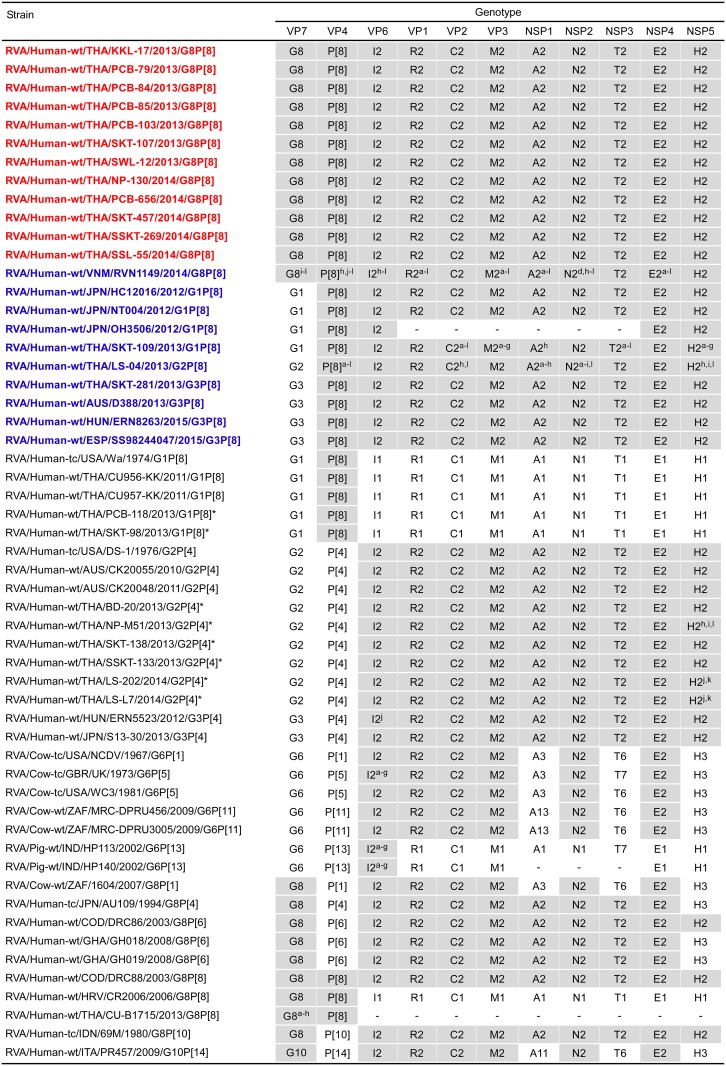
Genotype natures of the 11 gene segments of 12 Thai DS-1-like intergenogroup reassortant strains having G8P[8] genotypes, KKL-17, PCB-79, PCB-84, PCB-85, PCB-103, SKT-107, SWL-12, NP-130, PCB-656, SKT-457, SSKT-269, and SSL-55, compared with those of selected human and animal strains.The 12 study strains are shown in red, while other DS-1-like intergenogroup reassortant strains are shown in blue. Asterisks indicate co-circulating strains, PCB-180, SKT-98, BD-20, NP-M51, SKT-138, SSKT-133, LS-202, and LS-L7, reported in this and the preceding studies [19]. Gray shading indicates the gene segments with genotypes identical to those of the 12 strains. “−” indicates that no sequence data were available in the DDBJ and EMBL/GenBank data libraries. aThe gene segments that are most similar to those of strain KKL-17. bThe gene segments that are most similar to those of strain PCB-79. cThe gene segments that are most similar to those of strain PCB-84. dThe gene segments that are most similar to those of strain PCB-85. eThe gene segments that are most similar to those of strain PCB-103. fThe gene segments that are most similar to those of strain SKT-107. gThe gene segments that are most similar to those of strain SWL-12. hThe gene segments that are most similar to those of strain NP-130. iThe gene segments that are most similar to those of strain PCB-656. jThe gene segments that are most similar to those of strain SKT-457. kThe gene segments that are most similar to those of strain SSKT-269. lThe gene segments that are most similar to those of strain SSL-55.